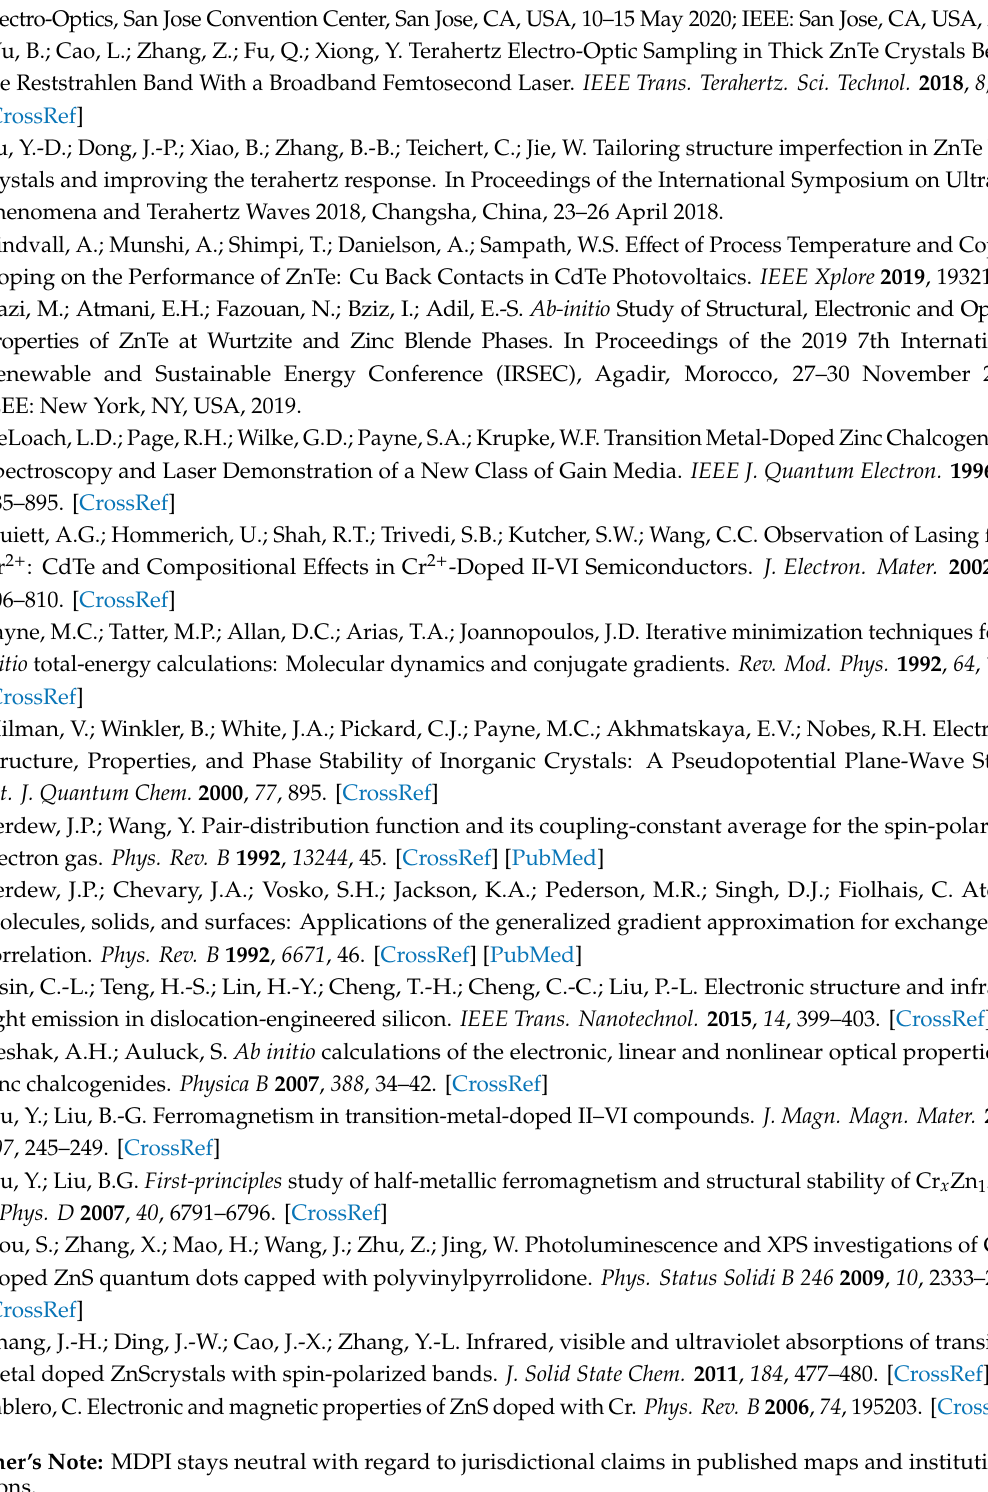
Tablero, C. Electronic and magnetic properties of ZnS doped with Cr. Phys. Rev. B 2006 , 74 , 195203.